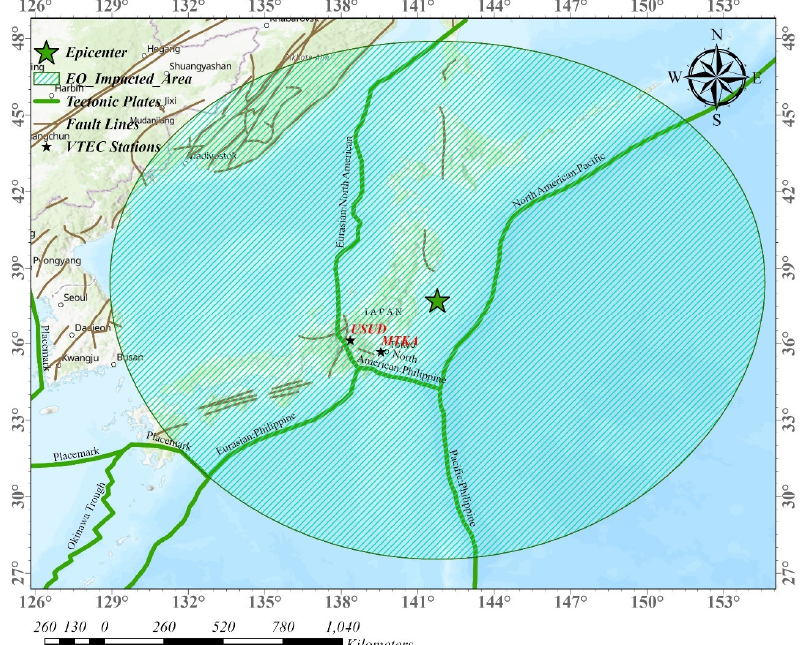
Figure 1. Geographical location of the 2021 M w 7.1, Japan earthquake (Lat = 37.7° N, Long = 141.7° E) with tectonic plates and fault lines. The epicenter is indicated by the green star and the GNSS stations are indicated by black stars and the shaded circle area is the earthquake-impacted area estimated by the Dobrovolsky formula.